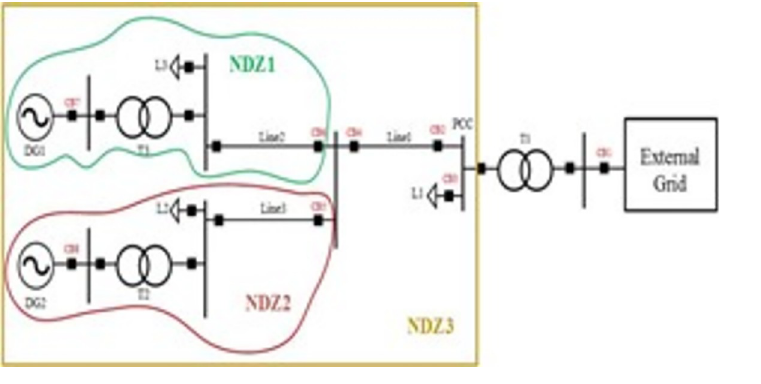
Fig 1. The system under study [40].